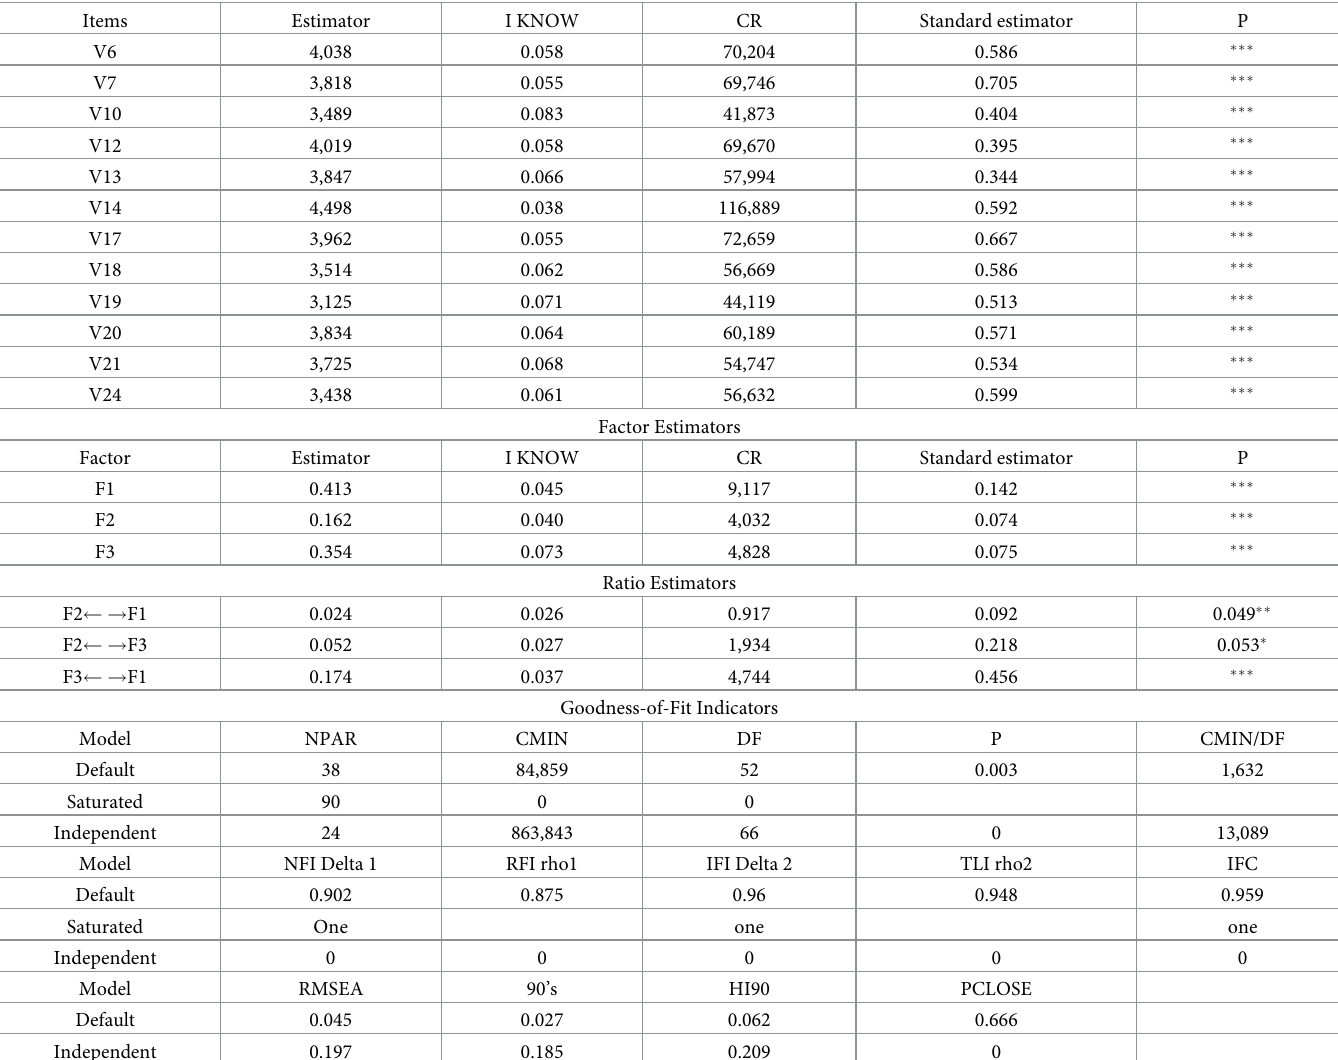
Table 3. Estimators of the covariance